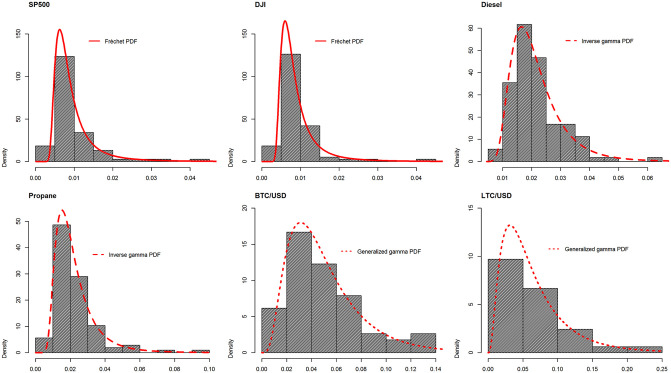
Histogram of standard deviations computed over non-overlapping windows of length 50 days for the specified daily log-returns (S&P500, DJI, Diesel, Propane, BTC and LTC).